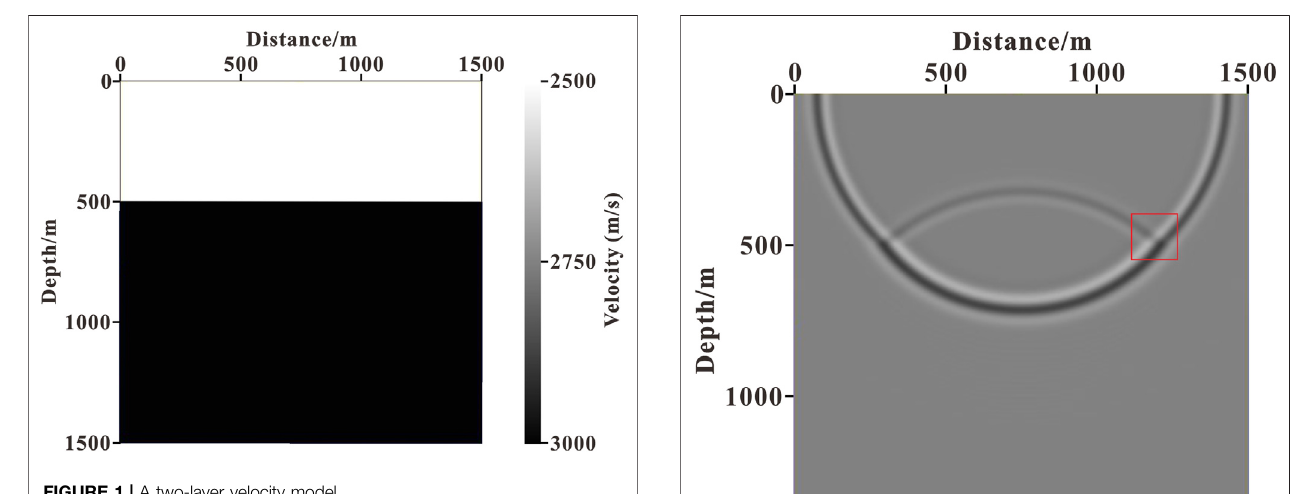
FIGURE 1 | A two-layer velocity model.